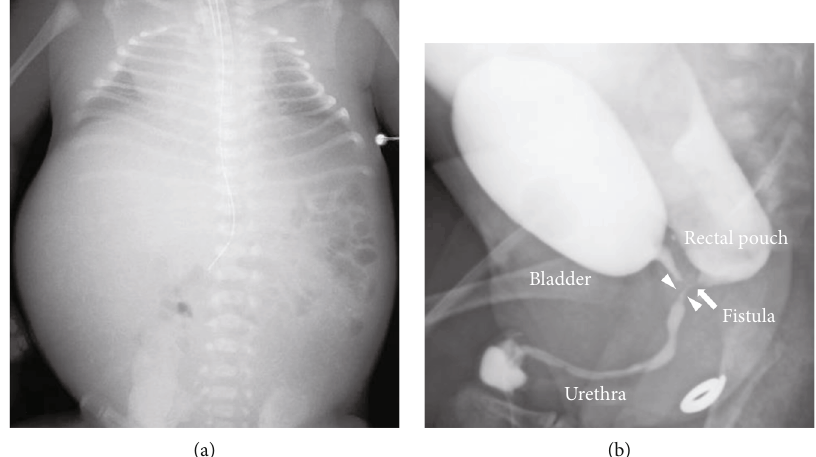
Figure 3: Neonatal chest X-ray and cystourethrography: (a) chest X-ray on day 1 showing poor lung expansion and abdominal expansion; (b) cystourethrography showing a patent rectourethral prostatic fi stula into the rectal pouch and a patent urethra. The arrowheads indicate urethral stenosis distal to rectourethral fi stula. The arrow indicates rectourethral prostatic fi stula.